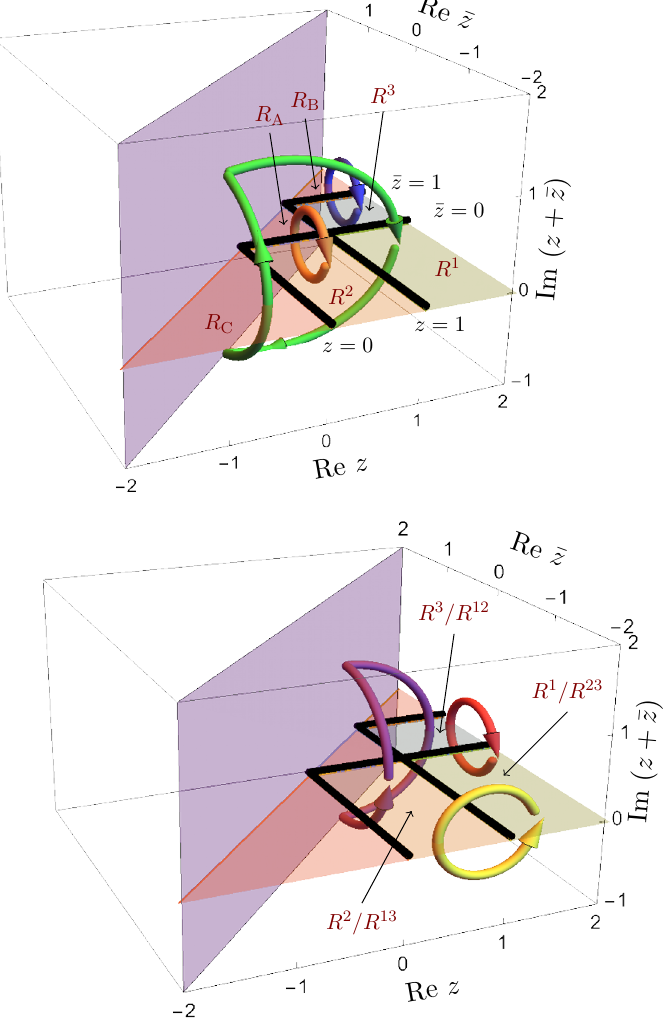
Figure 7 . Analytic continuation of three-point and four-point ladder diagrams takes place in the four-dimensional space of complex z and ¯ z . Sample paths of analytically continuing the energies are shown. The figure on the left depicts contours that are relevant for computing sequential dis- continuities in a single channel: R 1 → R ? → R 1 , R 2 → R ? → R 2 and R 3 → R ? → R 3 . The figure C A B on the right depicts paths relevant for computing sequential discontinuities in different channels: R 23 → R 2 → R 23 , R 13 → R 3 → R 13 and R 23 → R 3 → R 23 . These paths each encircle some combi- nation of the branch hypersurfaces shown as black lines, corresponding to where z or ¯ z are equal to either 0 or